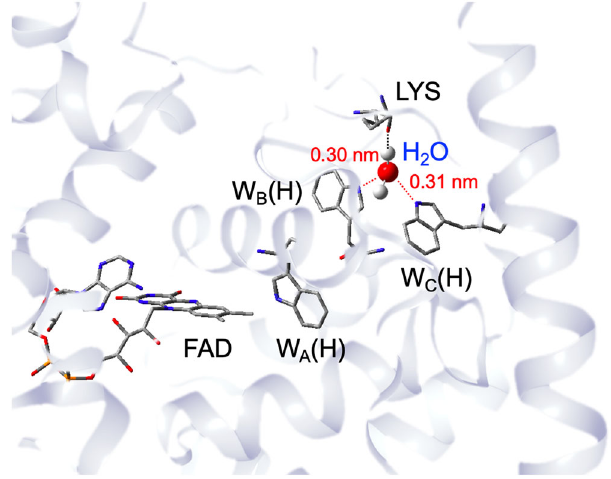
Fig. 1 Water binding between W B (H) and W C (H) forming an electron- tunneling route in chryptochrome. X-ray structure of the animal-like cryptochrome of Chlamydomonas reinhardtii (PDB code:5ZM0) with the Trp triad comprising W A (H), W B (H) and W C (H) 17